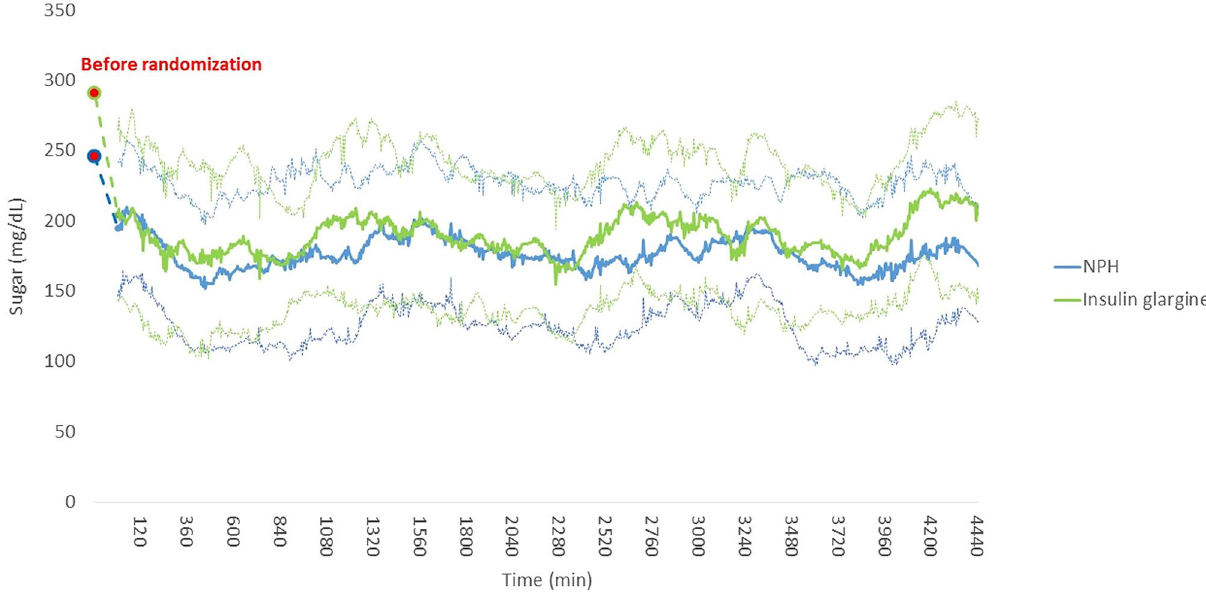
Figure 1. The line graphs of the average and standard deviation of glucose levels at prerandomization and during the 72-h intervention period in insulin glargine and NPH insulin